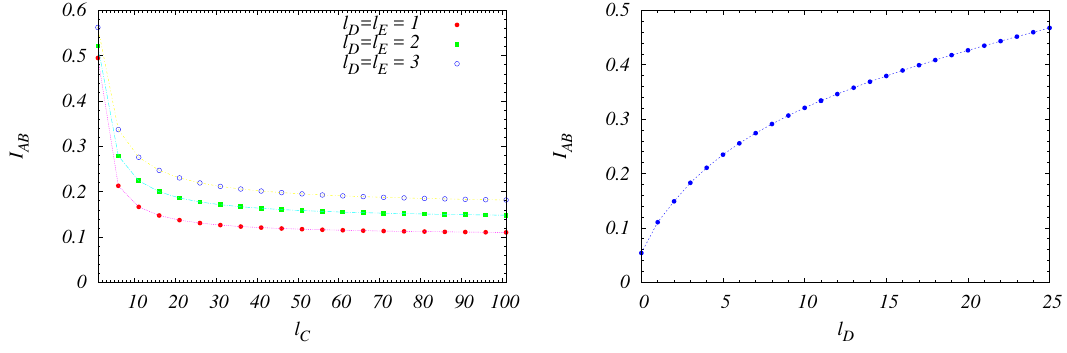
Figure 12: (Left) Mutual information between two spins in the bulk of a colorless = (cid:96) = 1,2,3 from the edges, as a function of the Motzkin chain at distances (cid:96) D E relative distance (cid:96) ; (Right) Mutual information between two spins in the bulk as a C = (cid:96) function of the distance (cid:96) from the edges for colorless Motzkin chain with size D E L =